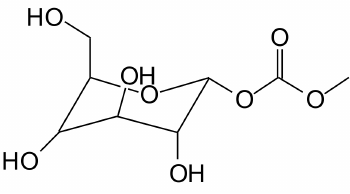
Figure 1. Monocarbonated glucose, peak at 263.8 Da.